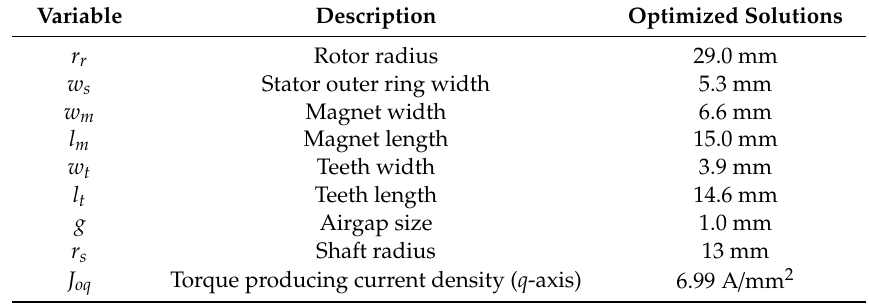
Figure 13. Current density and magnetic flux density. In ( a ) the torque producing current density 𝐽 𝑜𝑞 , the current density, J , and the maximum allowed thermal current density, 𝐽 𝑇ℎ , as a function of the torque, T , and in ( b ) the maximum value of flux density, B , as a function of the torque, T . Table 8. Optimization decision variables.